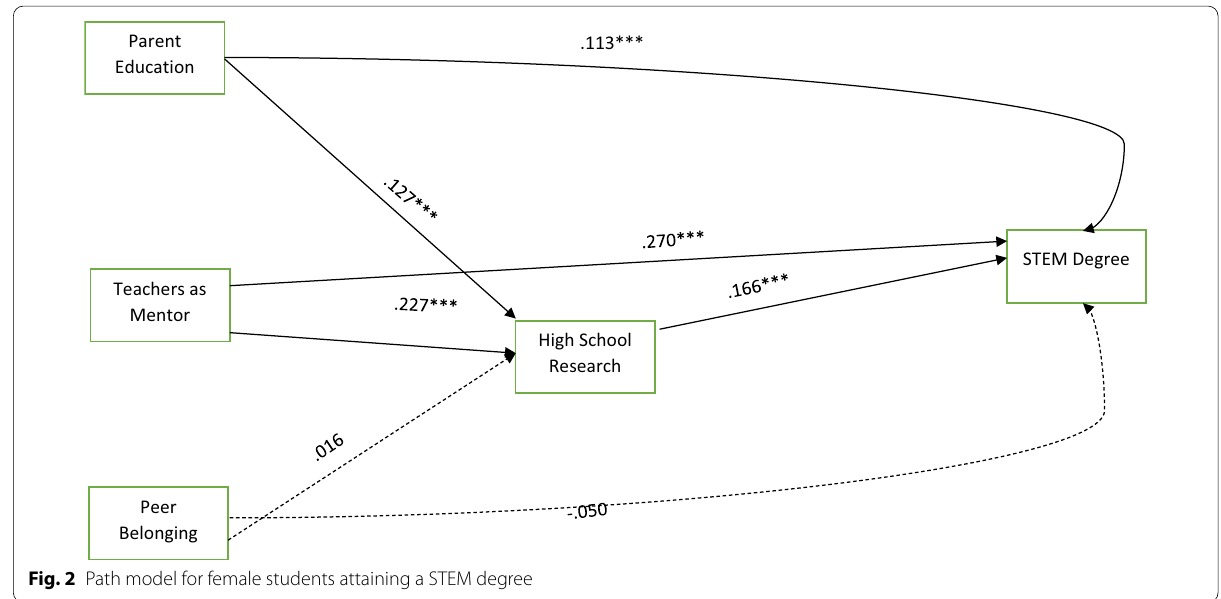
Fig. 2 Path model for female students attaining a STEM degree